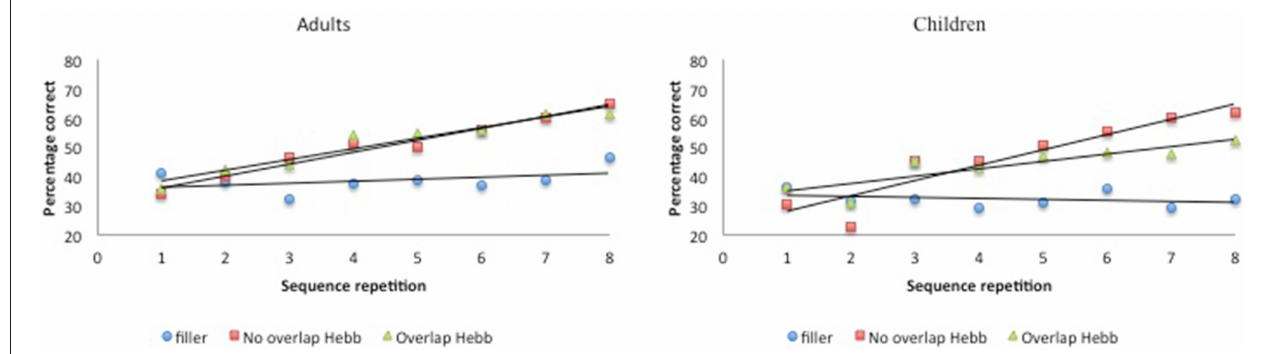
FIGURE 4 | Performance (percentage of correct scores) as a function of Sequence type (filler vs. Hebb non-overlap vs. Hebb overlap) and Sequence repetition (1–8) in both children and adults, Experiment 2. Left panel: performance for adults. Right panel : performance for children.